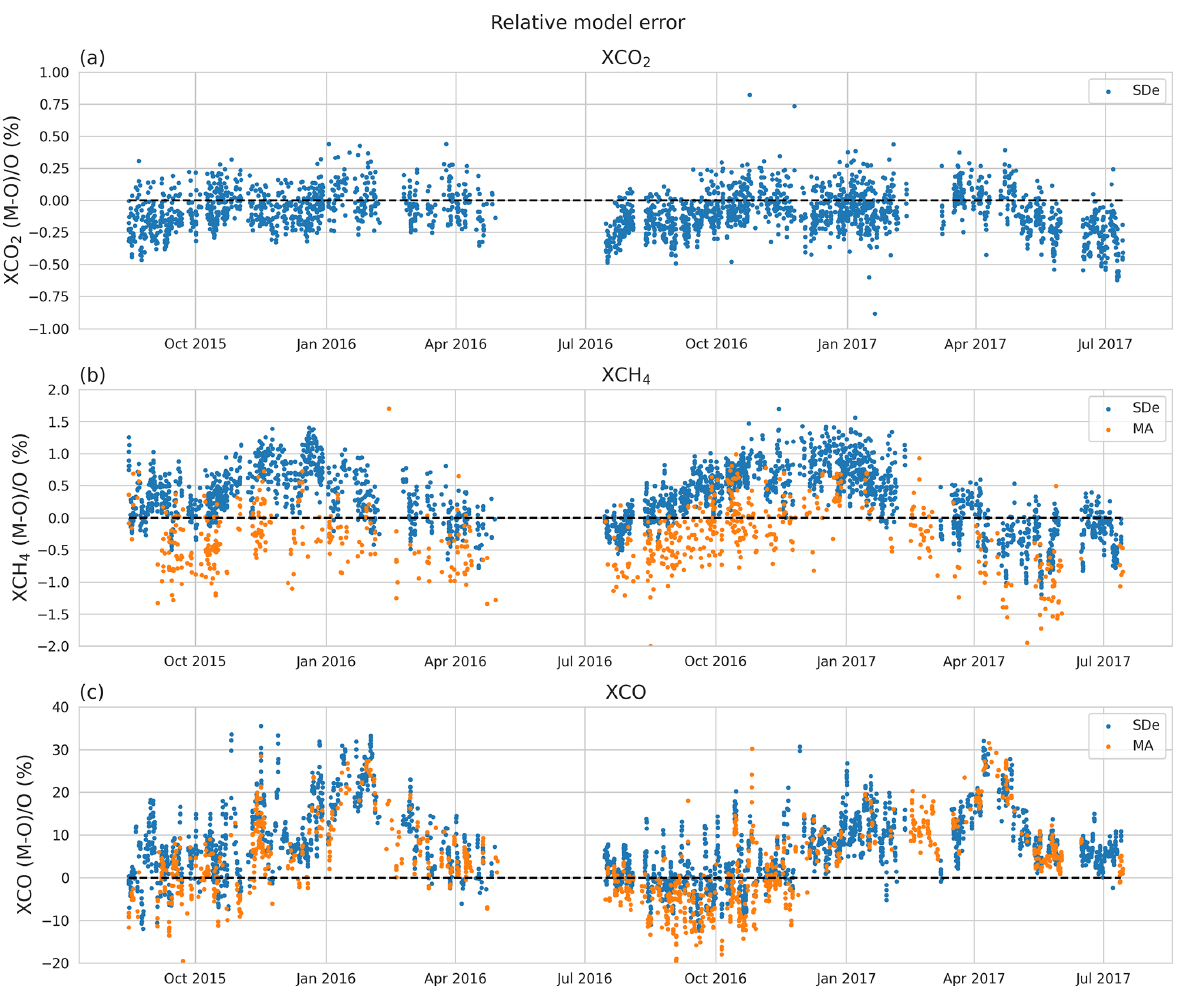
Figure 10. Relative percentage differences between hourly (smoothed) WRF-GHG and FTIR observations of XCO 2 , XCO, and XCH 4 . The blue dots represent the data at SDe (WRF–TCCON), while the orange data are from MA